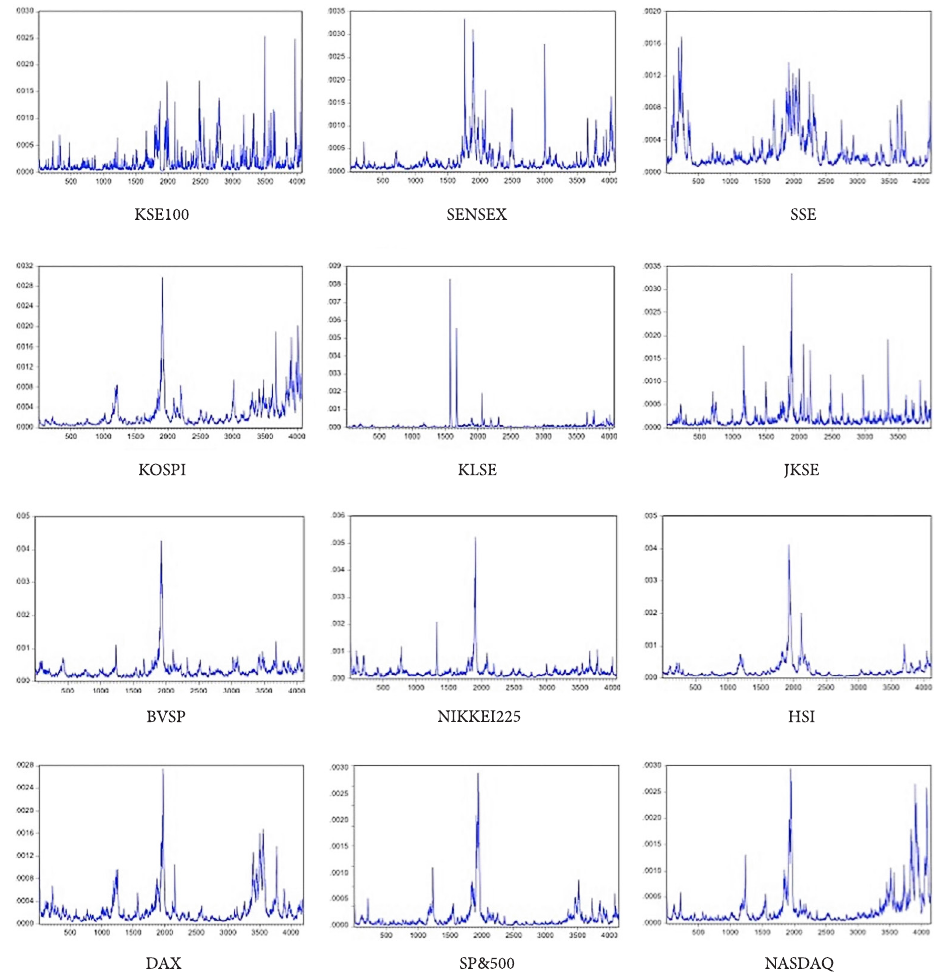
Fig. 4. Conditional variances for emerging and developed stock